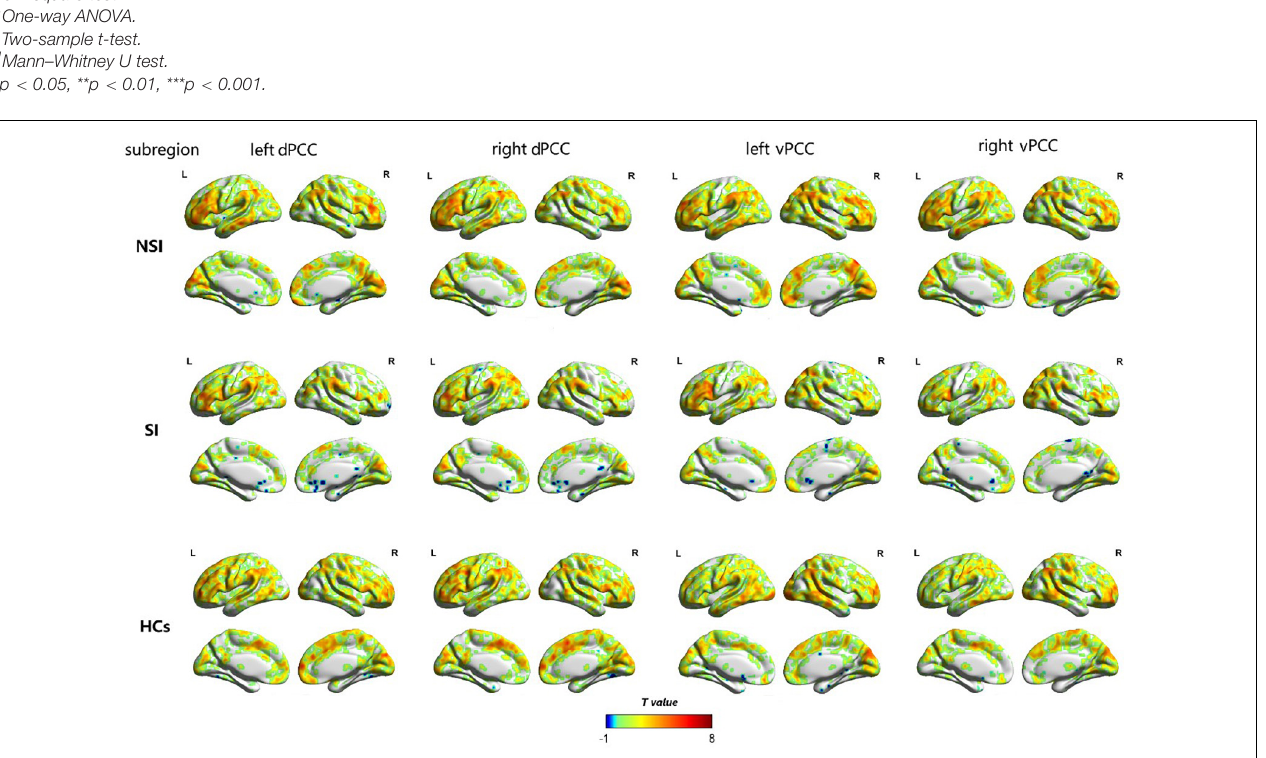
MDD patients without SI, while dFC variability